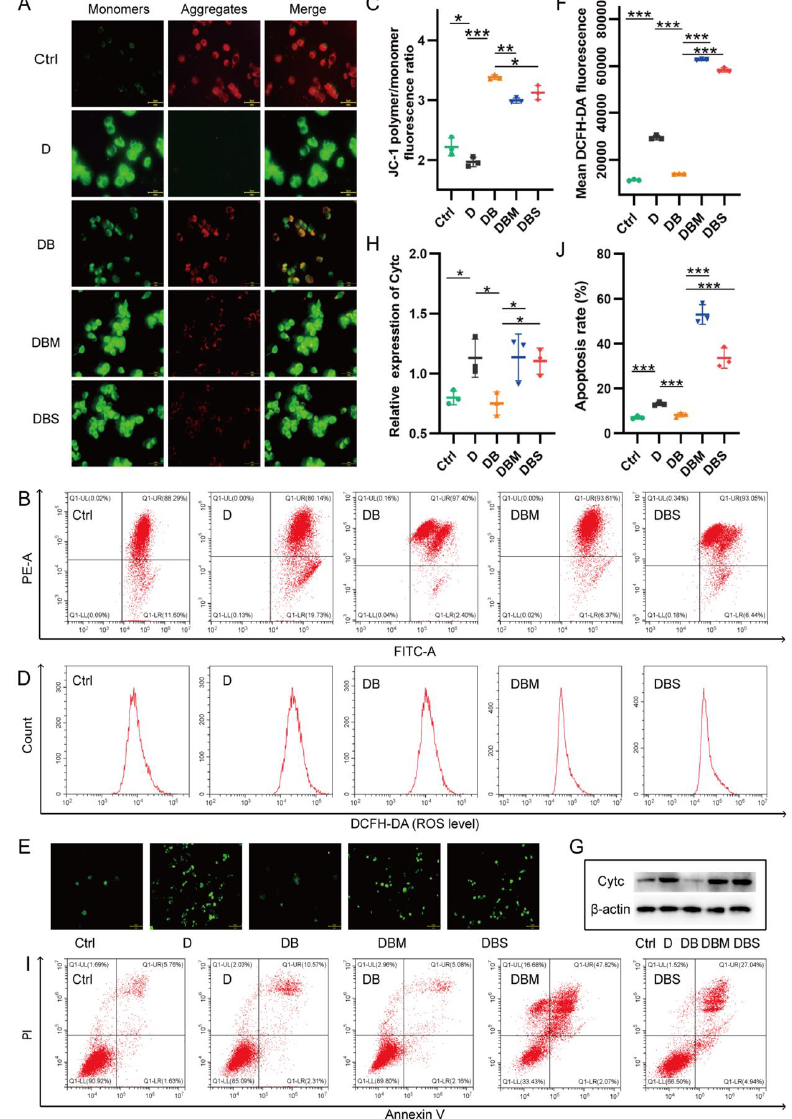
Figure 1. Berberine inhibits D-ribose-induced mitochondrial dysfunction by promoting mitophagy. Flow cytometry analysis of ∆Ψ m showed that the D group had weakened red fluorescence, enhanced green fluorescence, and a decreased ratio of the JC-1 aggregate/JC-1 monomer fluorescence compared with the control group ( A – C ). ∆Ψ m increased after the treatment with BBR (DB group), but decreased again after the addition of Midivi-1 (DBM group) or siRNA knockdown of PINK1 (DBS group). The results of ROS production ( D – F ), Cytc expression ( G , H ), and apoptosis ( I , J ) in each group showed the same trend as the results of ∆Ψ m. * p < 0.05, ** p < 0.01, *** p < 0.001. ∆Ψ m was determined using JC-1 staining with flow cytometry and IF ( A – C ). Scale bar = 5 µ m. ROS measured by flow cytometry and IF ( D – F ). Scale bar = 10 µ m. The cytochrome c in the cytoplasm of N2a cells was detected using WB ( G , H ). Detection of apoptosis by flow cytometry ( I , J ). Abbreviation: Ctrl, Control; D, D-ribose; DB, D-ribose + BBR; DBM, D-ribose + BBR + Mdivi-1; DBS, D-ribose + BBR +